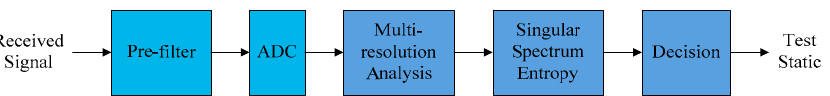
Figure 4. Block diagram of the non-cooperative spectrum sensing algorithm based on multi-resolution singular spectrum entropy.